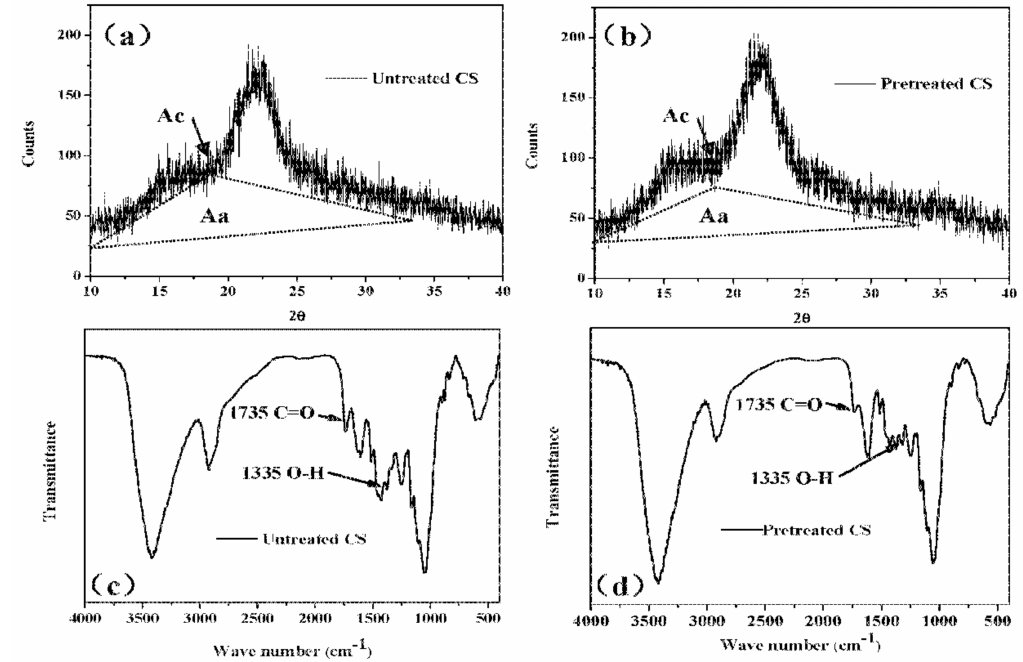
Figure 1. X-ray diffraction patterns and FTIR spectra of: ( a , c ) untreated corn straw (CS); and ( b , d ) pretreated CS with biogas liquid in the pilot-scale test. Ac and Aa represent the crystalline and amorphous portions of the X-ray diffractogram,